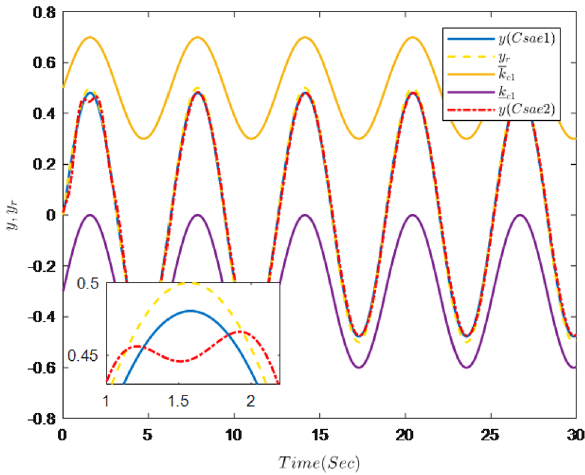
Figure 7. Trajectories of the output y , the reference signal y r and constraint interval.